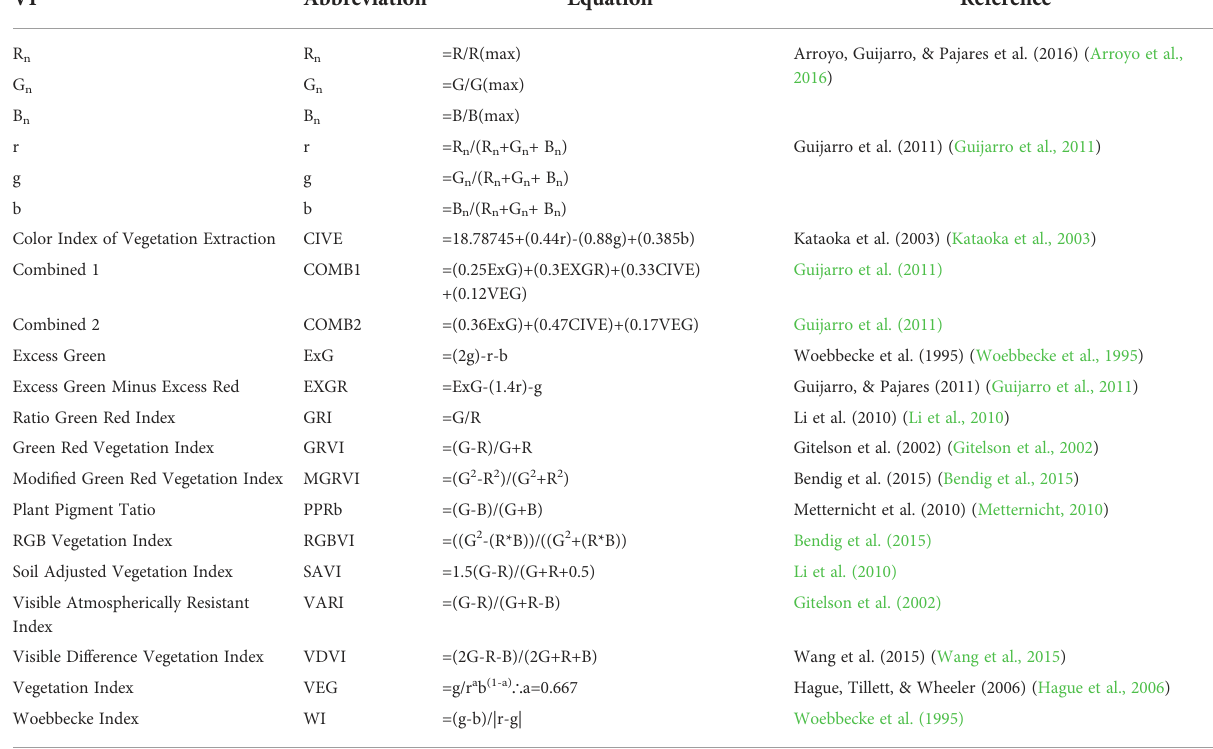
TABLE 2 Summary of the RGB-based vegetation index.